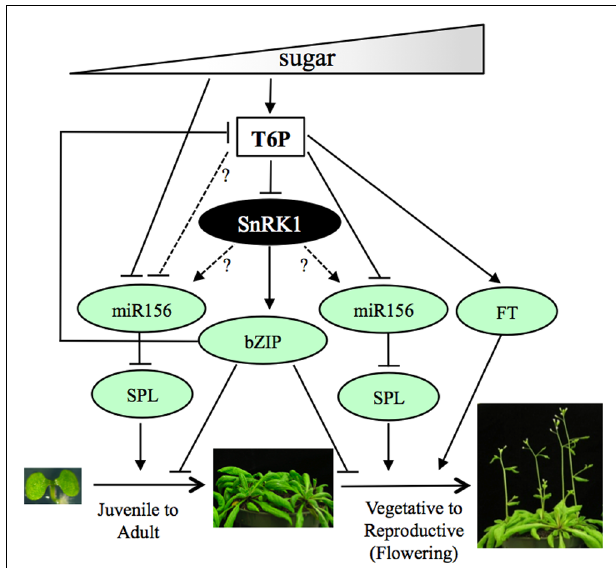
FIGURE 3 | Regulation of vegetative development and flowering by sugars throughT6P and SnRK1. Model showing regulation of vegetative development and flowering by sugars throughT6P and SnRK1. Sugars regulate vegetative and reproductive developmental phase transitions through the antagonistic action ofT6P and SnRK1.T6P inhibits SnRK1 activity in young leaves to promote growth, while SnRK1 delays vegetative growth and flowering in response to energy depletion through bZIP activation, which in turn repressesT6P accumulation.T6P promotes flowering through the photoperiod pathway by activating FT in the leaves and via the miRNA156/SPL age pathways at the SAM by inhibiting miR156. Sugars also regulate vegetative phase change through the miR156/SPL pathway by repressing miR156. Question marks and dotted lines denote possible relationships between genes and/or signaling molecules (see text for